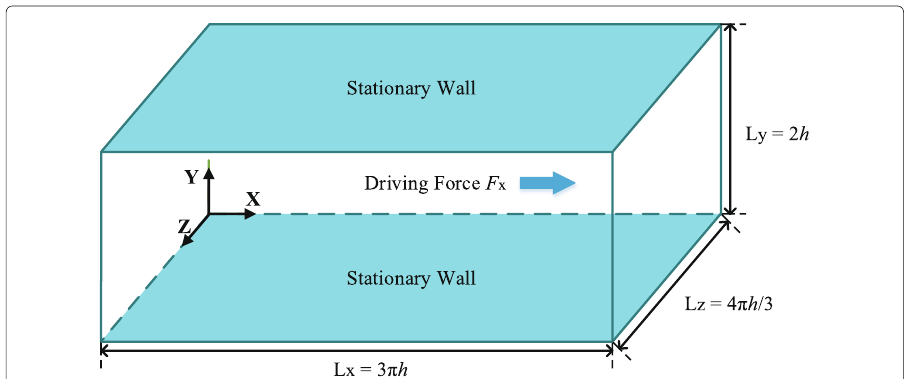
and spanwise directions. In order to resolve the wall layer, a non-uniform distribution of grid points (Fig. 2, the parameter α = 3.8) defined by Eq. (48) is used in the wall-normal direction.